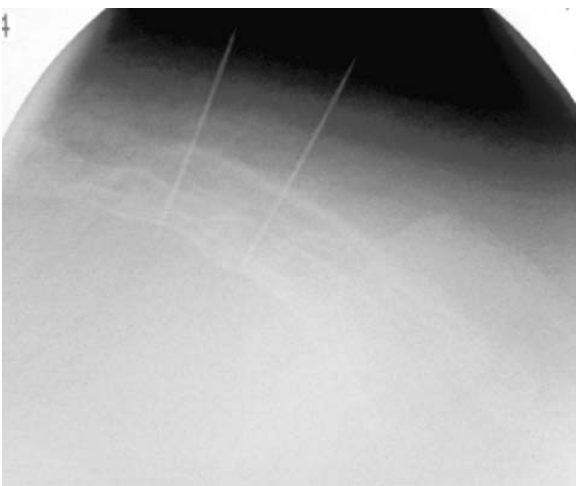
Figure 3 – Site of percutaneous placement of needle stimulations and stage I lead.